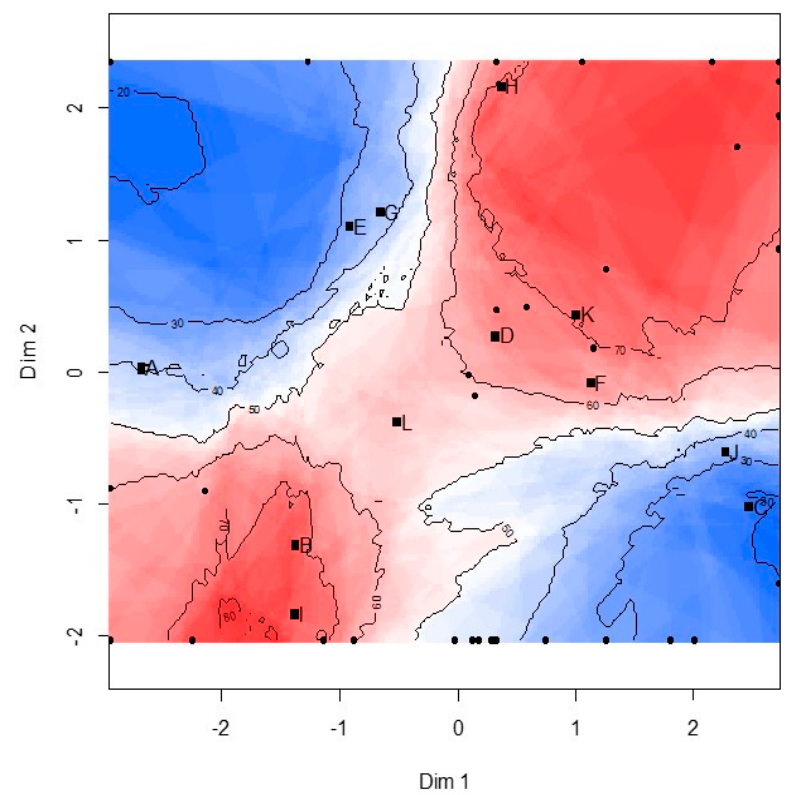
Figure 5. Preference mapping. A = P0T0: 0 t ha − 1 of poultry litter and N-P-K in Kg ha − 1 100-30-150, B